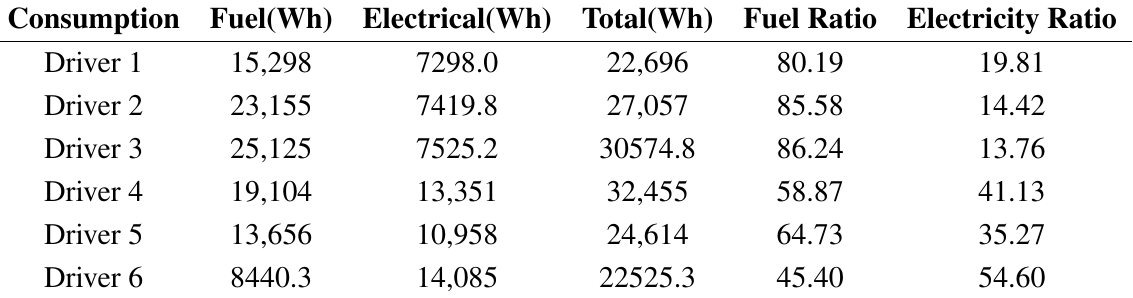
Table 5. Vehicle energy consumption breakdown of six drivers’ daily trips.